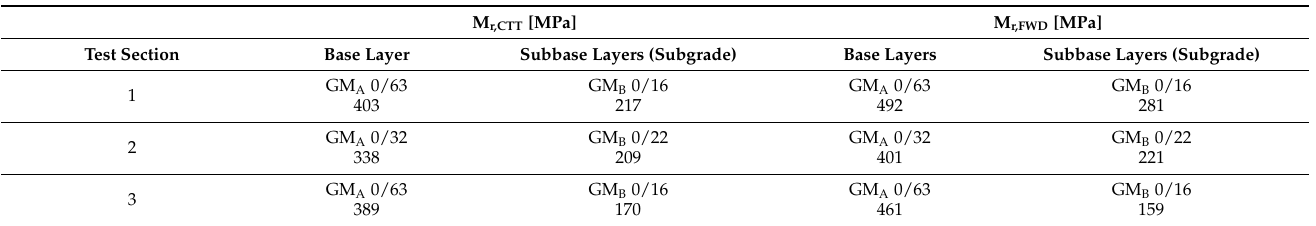
Table 4. Determined elasticity moduli of layers at the monitored sections at natural material humidity during the time of measurement.